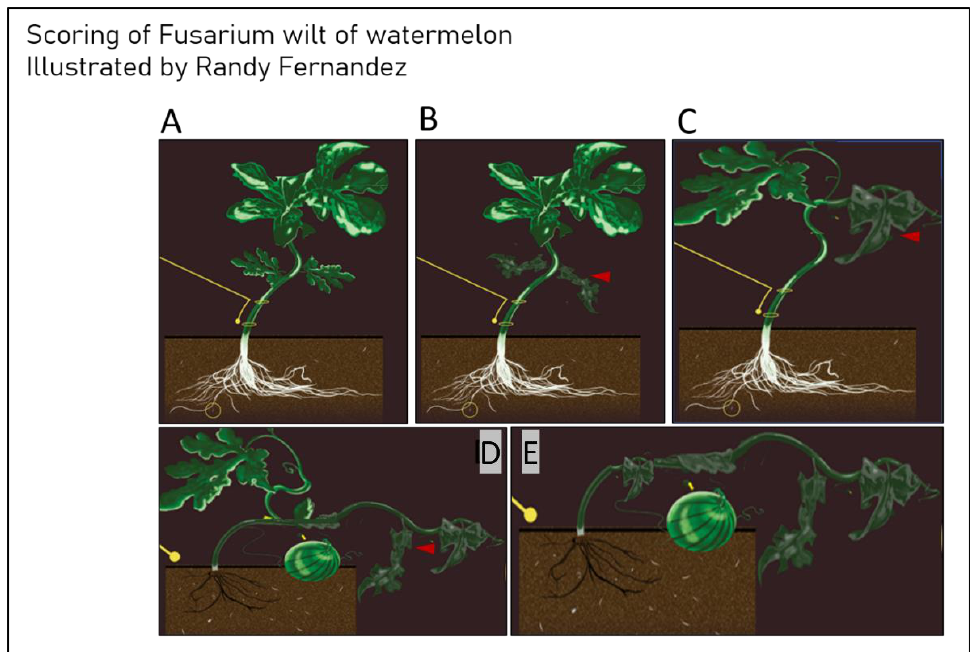
Figure 4. Visual differences in Fon symptoms on watermelon plants for scoring disease. ( A ) Score of 0, asymptomatic plants. ( B ) Score of 3, plants have cotyledon lesions. ( C ) Score of 5, plants are slightly wilted and stunted. ( D ) Score of 7, plants are severely wilted and stunted. ( E ) Score of 9, plants are dead.